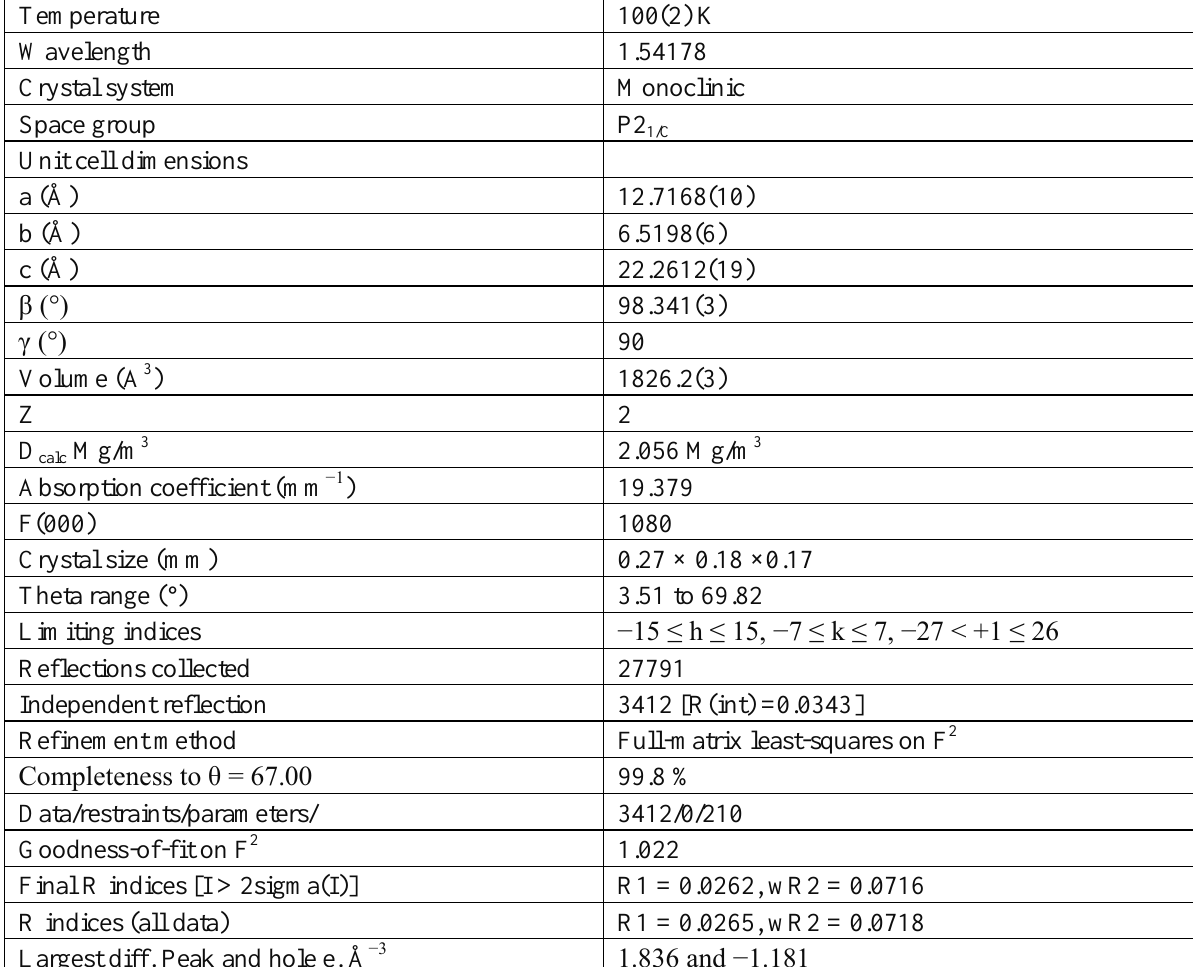
Table 3. Selected Bond length (Å) and Bond Angle (°) for [(C